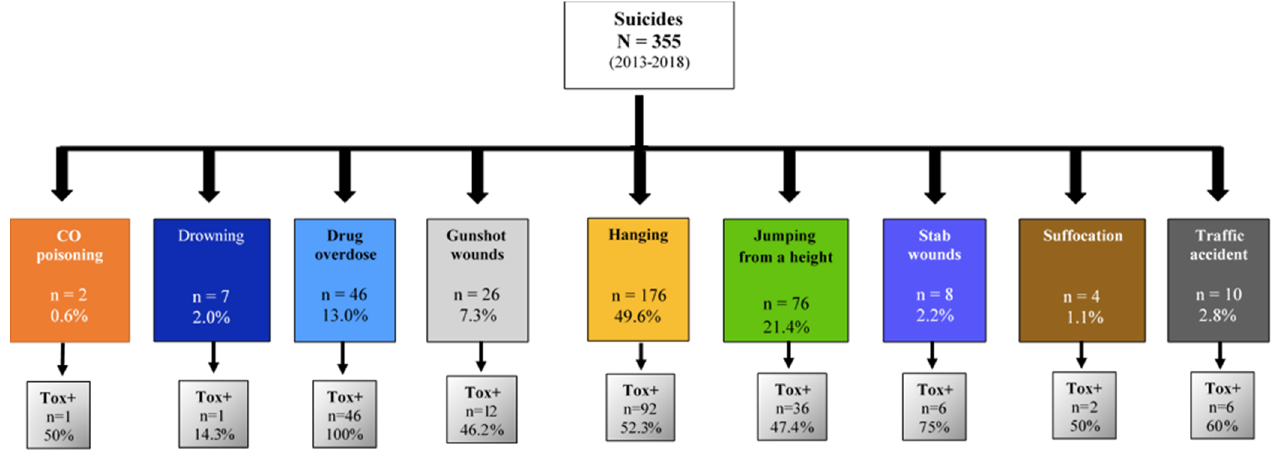
Figure 1. Scheme of the total suicides revised in this study classified by the suicide mechanism and the presence of toxic substances in the cadaver. CO, carbon monoxide; N, total sample size; n, sample size of the different groups analyzed; Tox+, confirmation of the presence of toxic substances in the corpse.